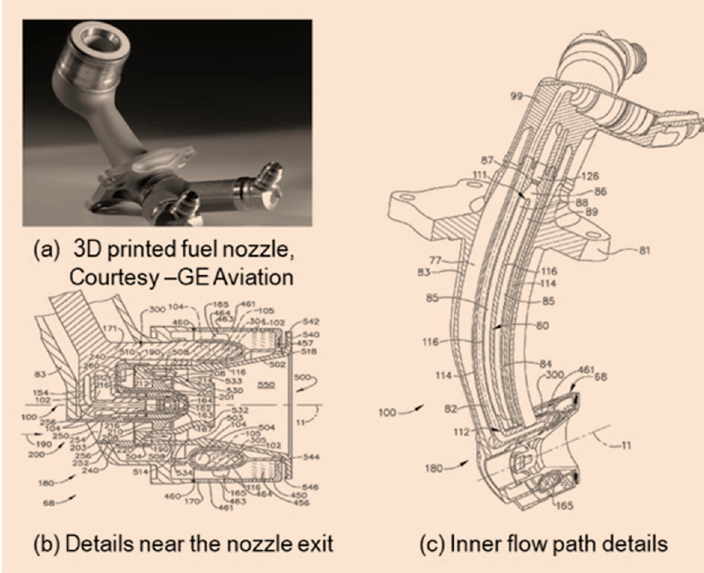
Figure 17. A successful implementation of AM in mass production is LEAP engine fuel nozzle (images [108,109]).